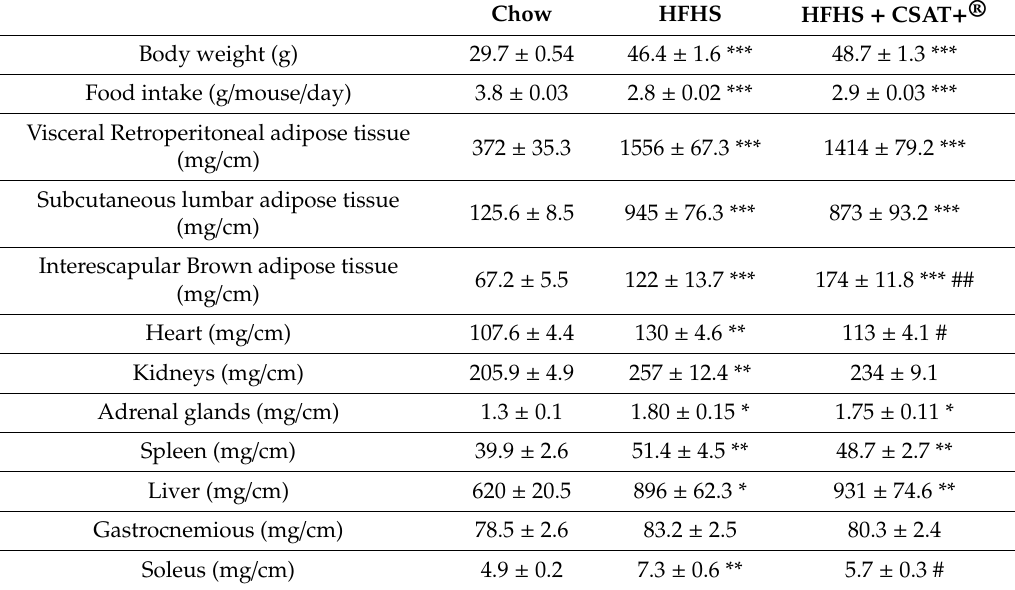
Table 2. Body weight, daily food intake and weights of retroperitoneal visceral adipose tissue, lumbar subcutaneous adipose tissue, interscapular brown adipose tissue, heart, kidneys, adrenal glands, spleen, liver, gastrocnemius, and soleus of mice fed either a standard diet (chow) or a high fat / high sucrose diet (HFHS) supplemented or not with carob fruit extract (CSAT + ® ) for 26 weeks. Data are represented as mean ± SEM. ( n = 12 mice / group). * p < 0.05 vs. chow; ** p < 0.01 vs. chow; *** p < 0.001 vs. chow; # p